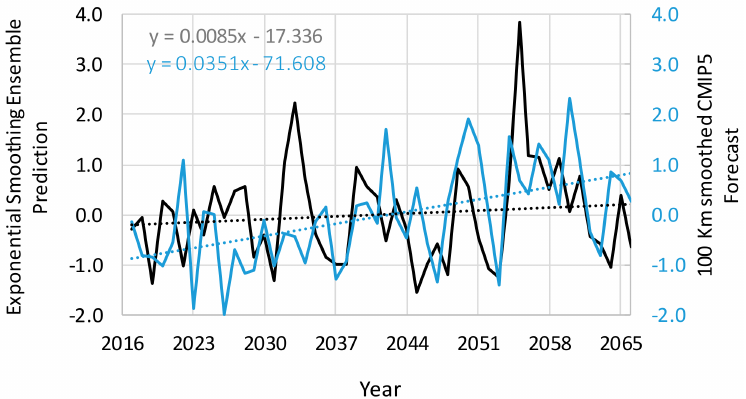
Figure 5. Standardised anomalies of forecasted daily maximum rainfall in Naples, by both exponential smoothing (black curve) and CMIP5 model mean (blue curve), as well as respective linear trends. The extreme value of about 130 mm, corresponding to a 100-year return period (red line), is overstepped one time within the forecasted period. Also, the interdecadal variability is pronounced, with the annual single values often approaching the 10-year return period of 93 mm (orange line), as estimated by GEV (generalized extreme value) distribution (Figure